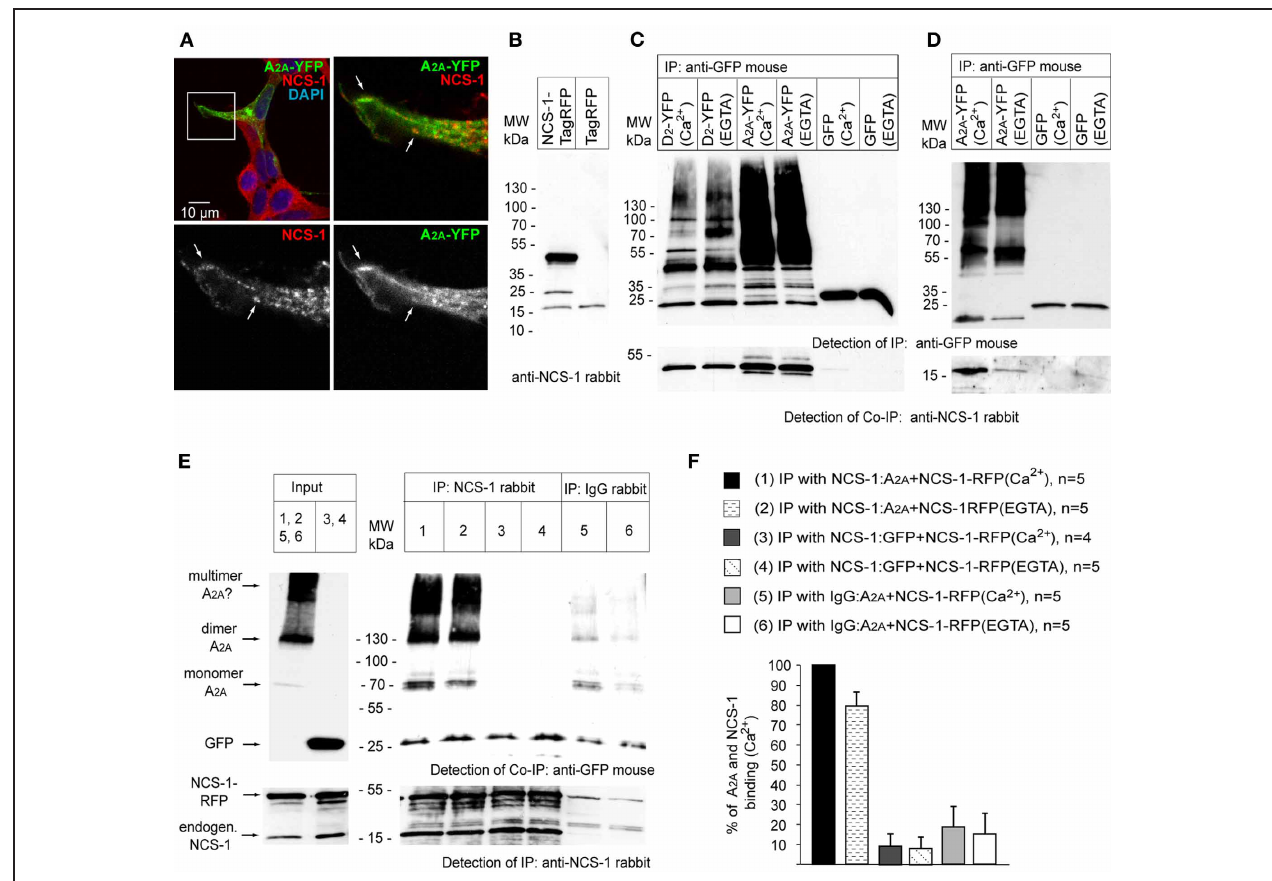
YFP-fused receptors or GFP control were detected with anti-GFP mouse antibody, detection of NCS-1-TagRFP was done with anti-NCS-1 rabbit antibody. (D) Endogenous NCS-1 is co-immunoprecipitated with A 2A -YFP from HEK293T cell extract. (E) Immunoprecipitation (IP) is performed